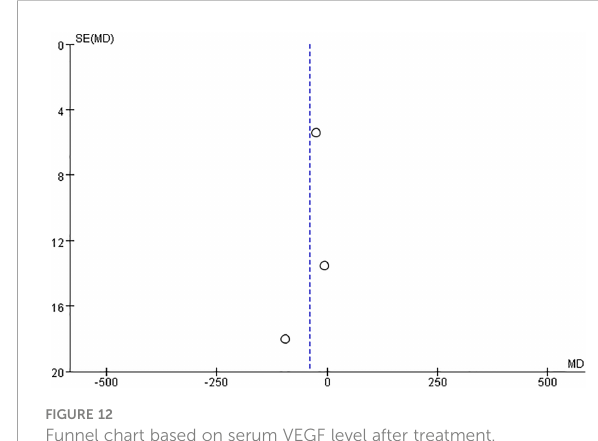
FIGURE 10 Funnel chart based on T lymphocyte subsets after treatment.